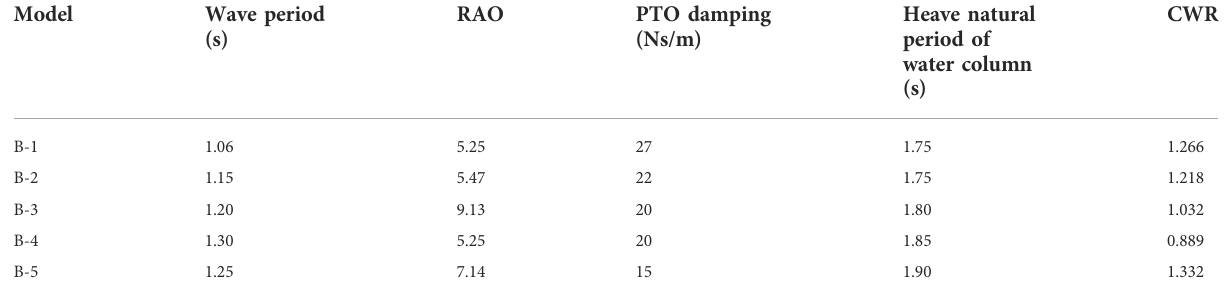
TABLE 4 Peak capture performance of model B with different drafts.